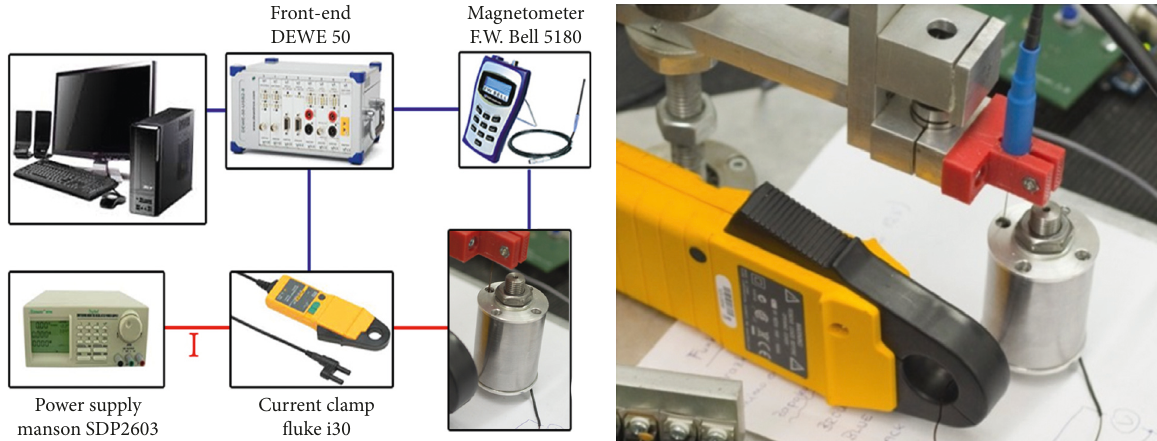
Figure 9: Test rig